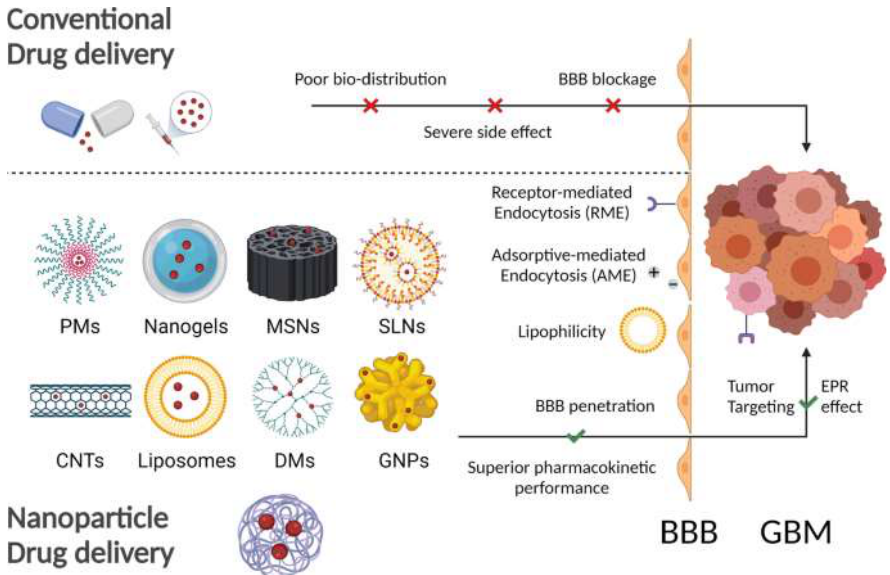
Figure 5. Representation of different nanoparticles such as polymer nanoparticles (PMs), nanogel, mesoporous silica nanoparticles (MSNs), solid lipid nanoparticles (SLNs), carbon nanotubes (CNTs), liposomes, dendrimers (DMs), and gold nanoparticles (GNPs) and how they can overcome the limitations of traditional anticancer treatment